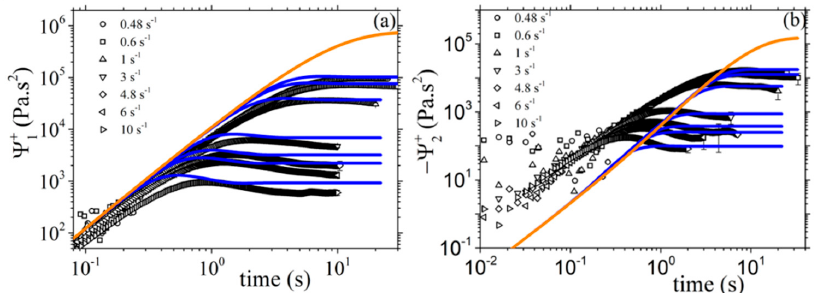
Figure 8. Comparison of the model predictions with the experimental data of Ref. [17] for the growth of the first ( a ) and second ( b ) normal stress coefficients, upon inception of shear flow. The thick orange lines depict the LVE envelope, Equations (15b) and (15c). Same parameter values as in Figure 6.